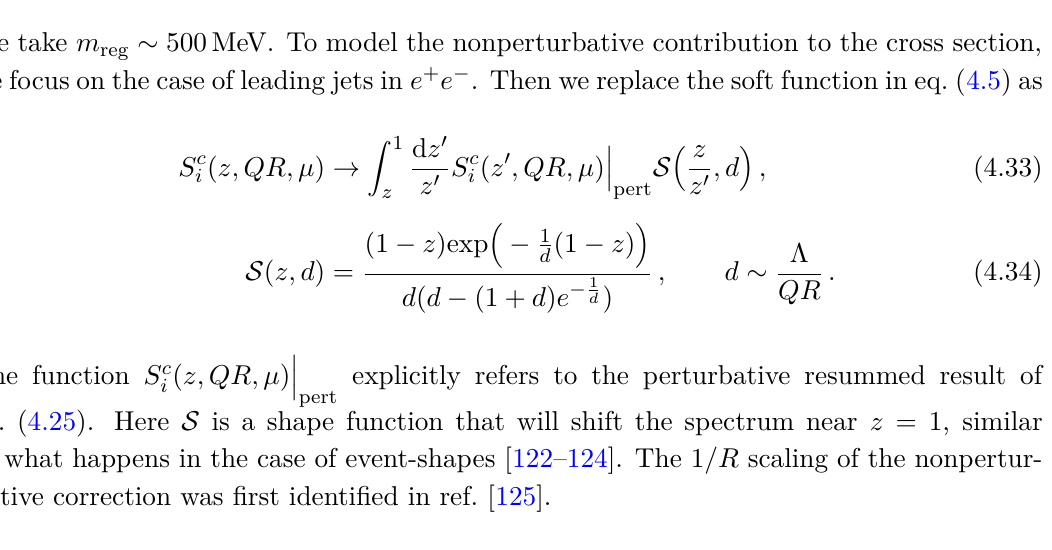
Figure 6 . Inclusive and leading jet spectra for quark/gluon e + e − hemisphere jets and 91 . 2